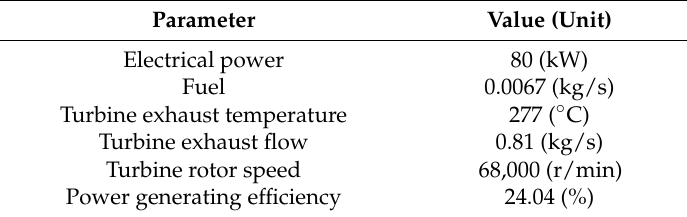
Table A1. Nominal design values of the MGT.